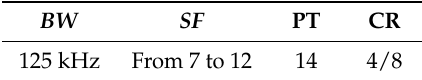
Table 2. Settings of the LoRa physical layer during